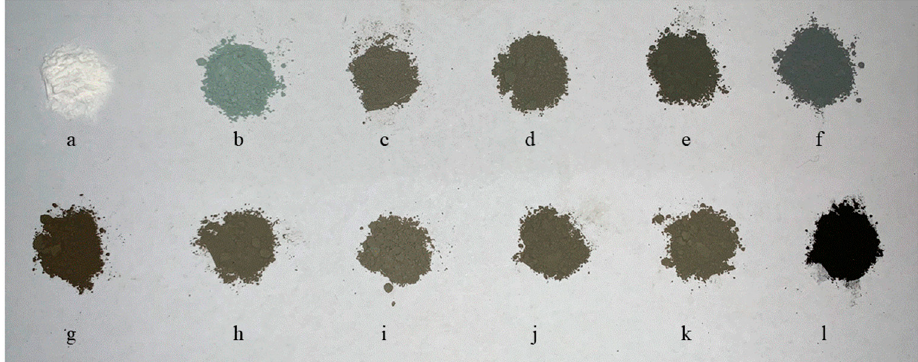
Figure 13. CATs samples investigated (samples in photo were broken into powders for Figure13.